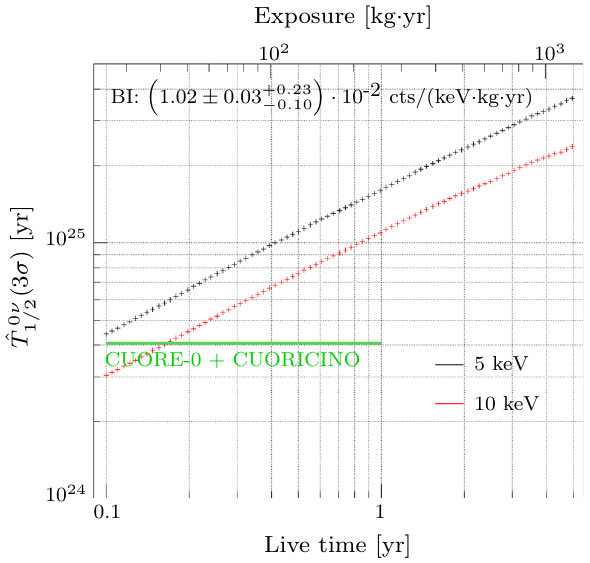
Fig. 3 3 σ discoverysensitivitywitha BI of1 . 02 · 10- 2 cts /( keV · kg · yr ) and an FWHM of 5